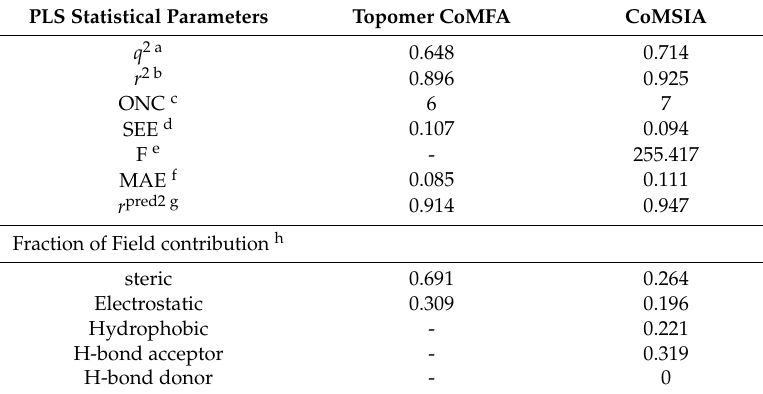
Table 1. The partial least squares (PLS) statistical parameters for the CoMFA and CoMSIA.